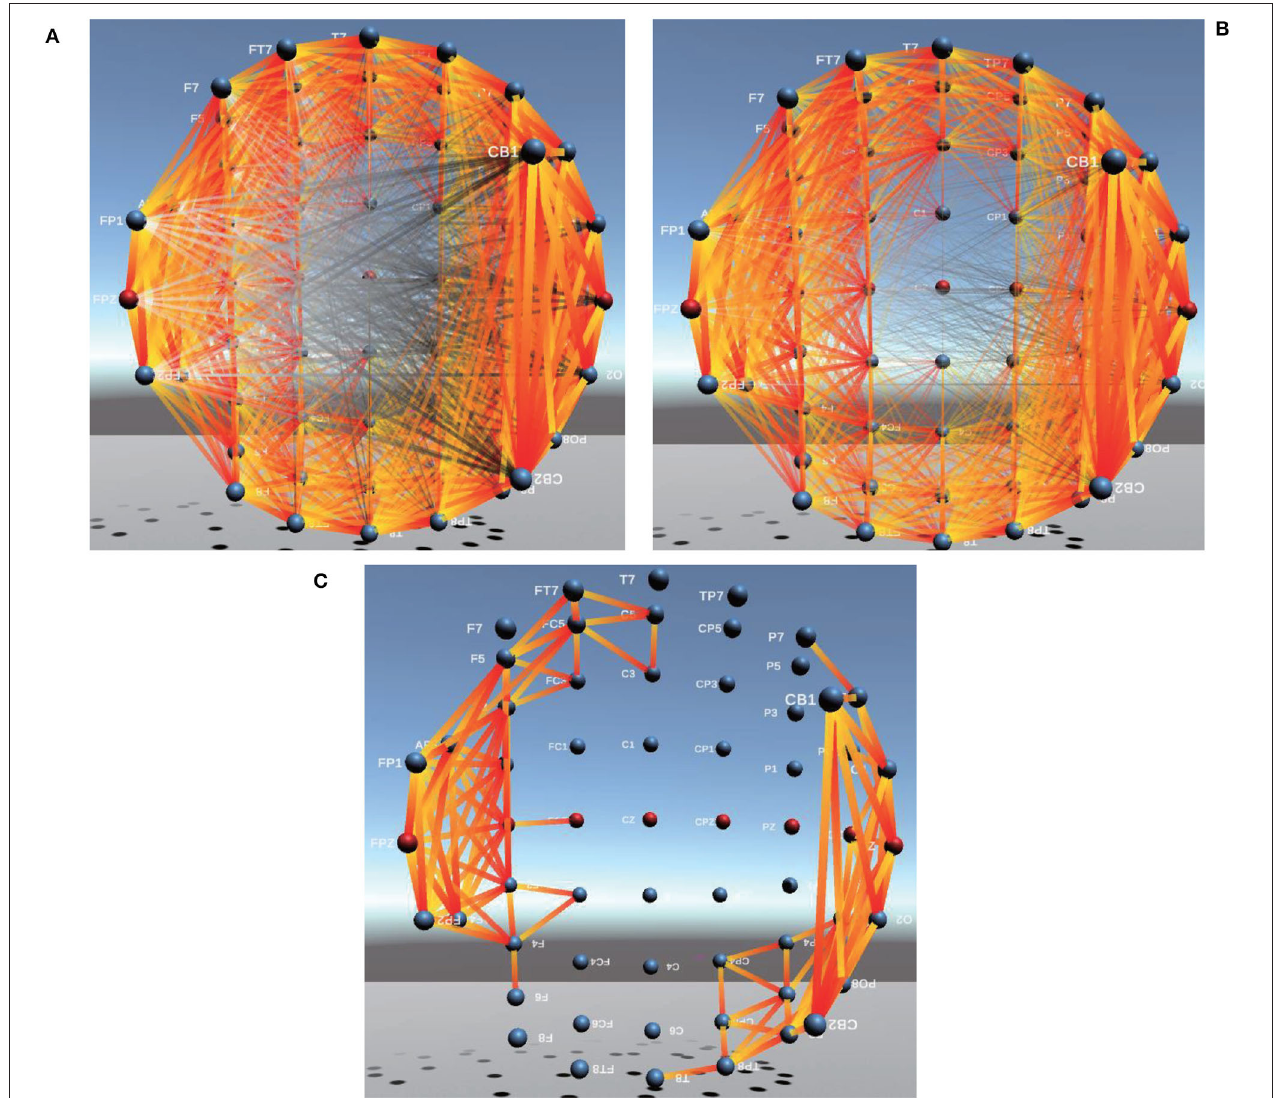
FIGURE 6 | Between-channel FC visualization of PCC and Comprehensive. (A,B) are between-channel FC visualization of PCC and Comprehensive. (C) is Between-channel FC visualization of 1/8 of